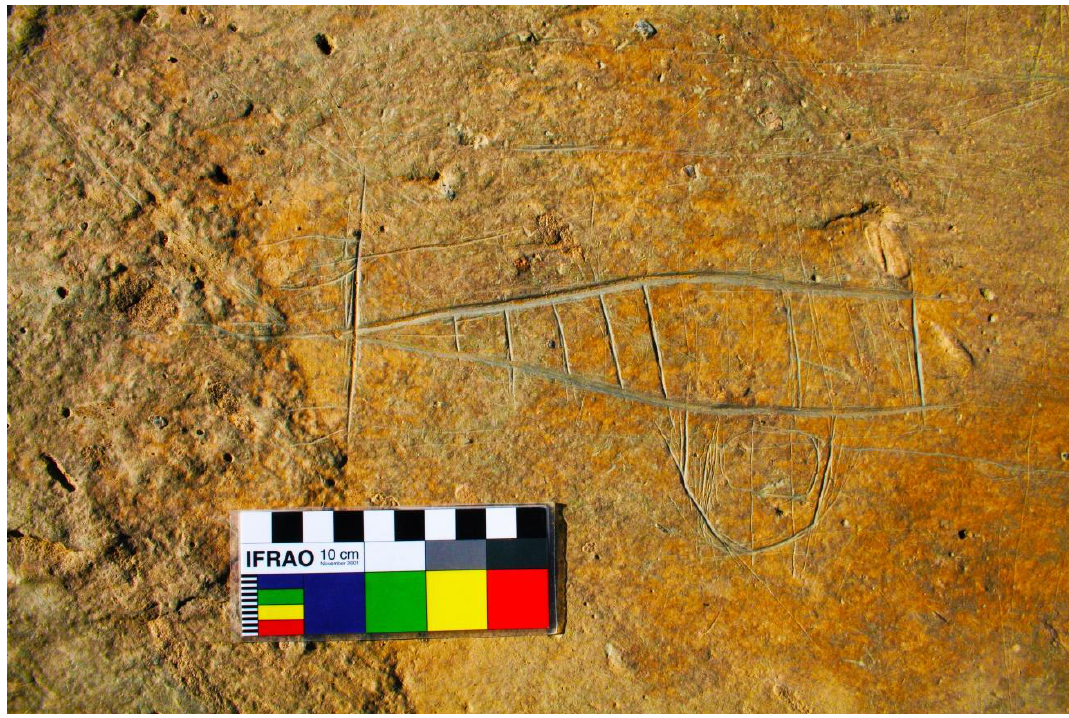
Figure 5. Image of the “chariot” nº 5 from La Roca de los Carros (Campanario).